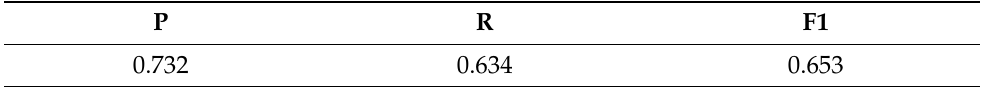
Table 2. 5W1H Information Extraction Method